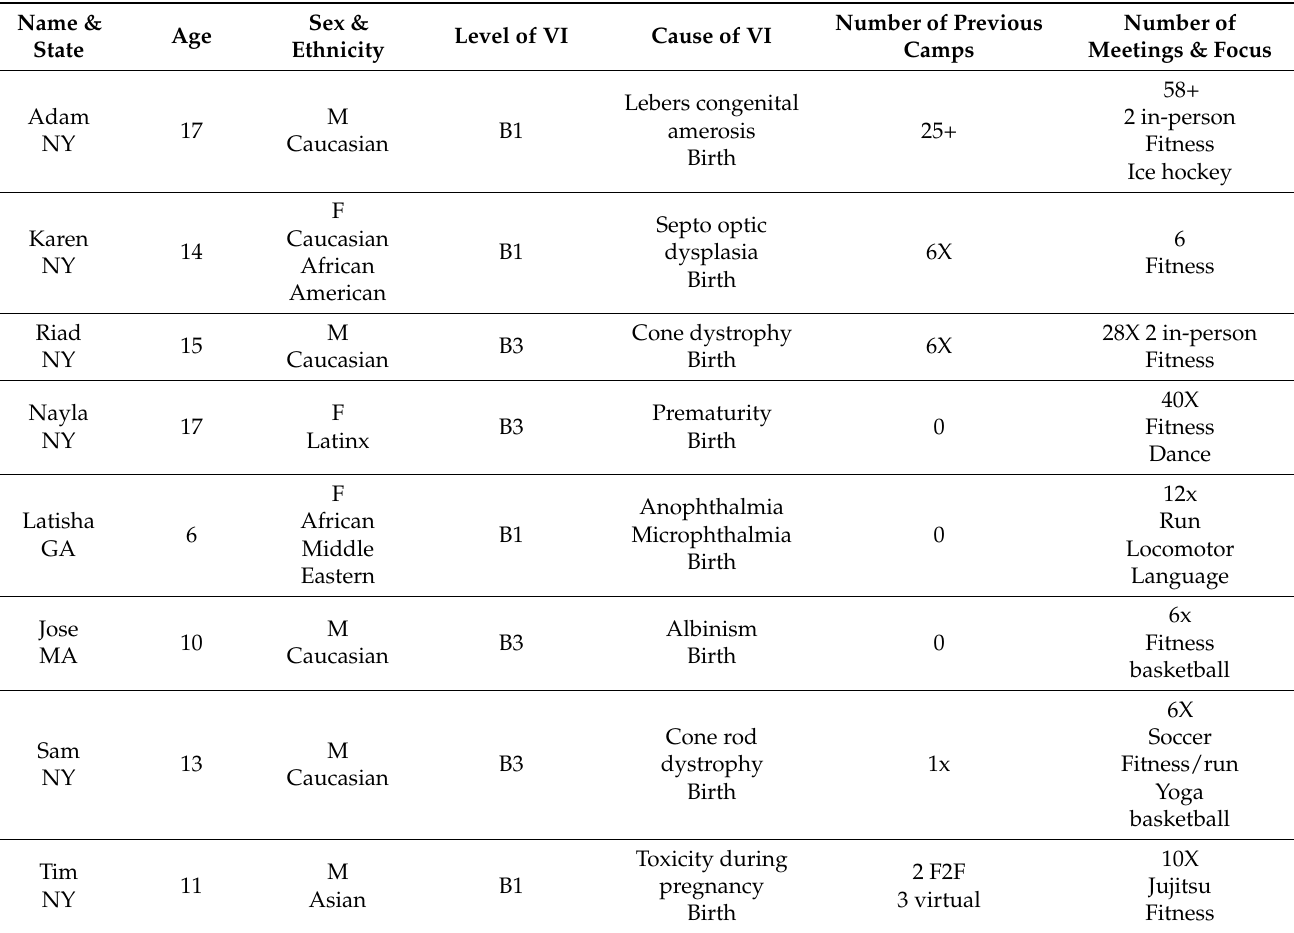
Table 1. Demographic